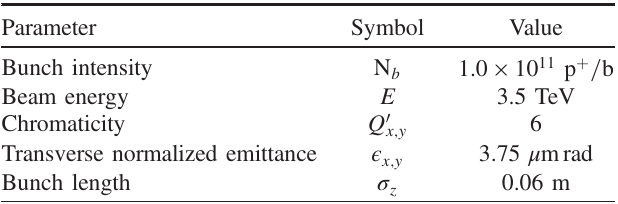
TABLE I. Main parameters used in P y HEADTAIL and B im B im to reproduce the LHC experimental machine setup at 3.5 TeV 2 = 2 β z z (green)